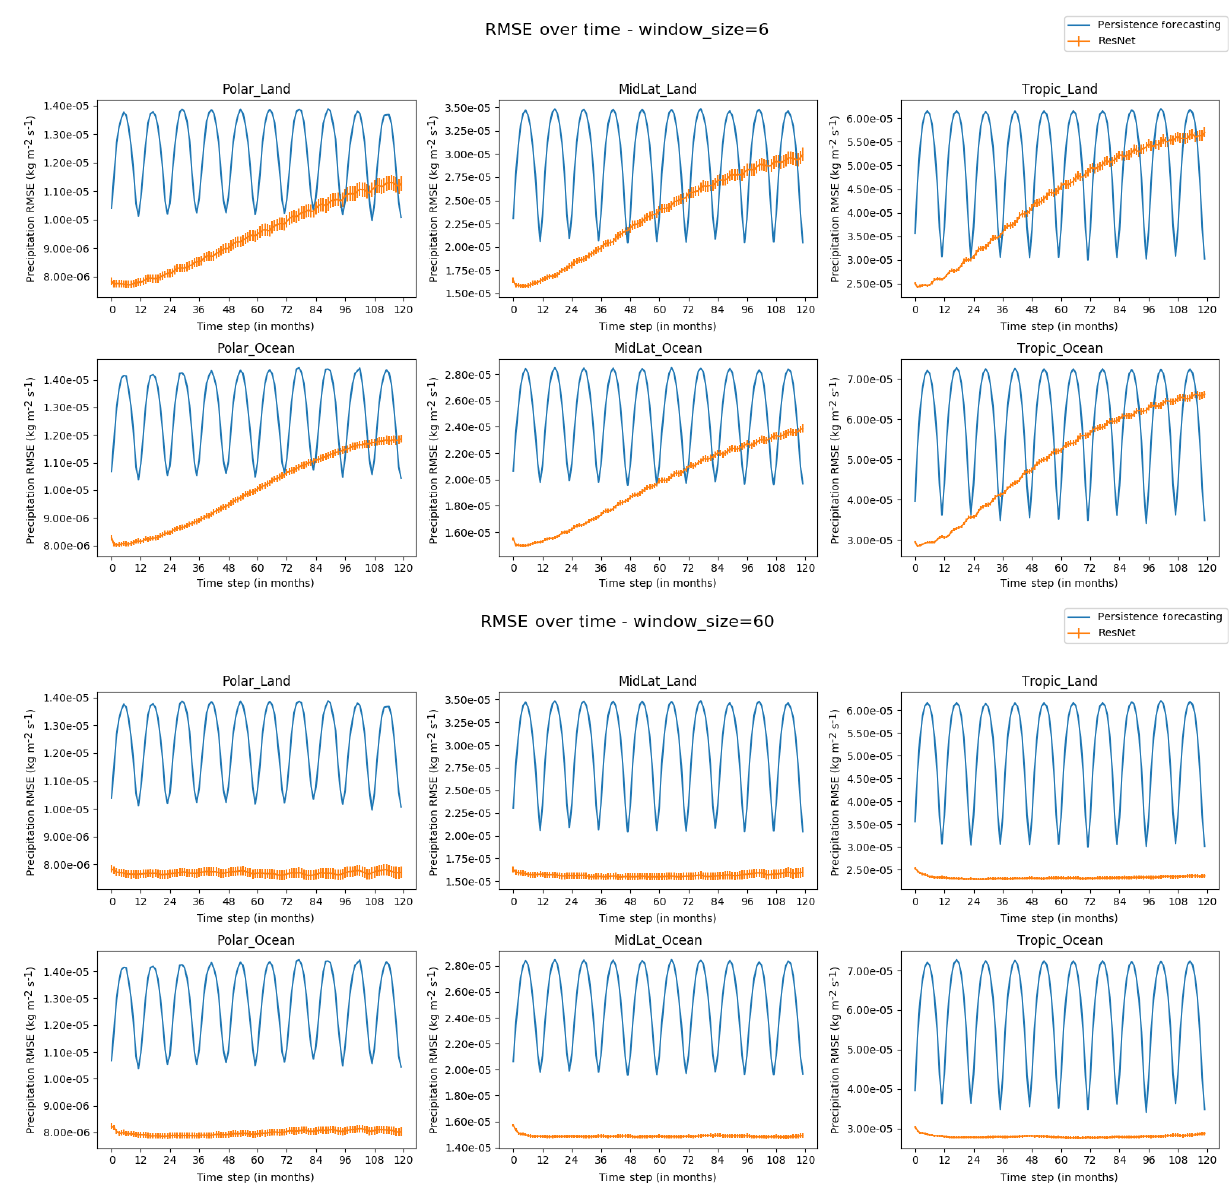
Figure A1. Comparing the RMSE for decadal precipitation forecasts in the 18-layer residual network with a 6-month window (top) and a 60-month window (bottom). Both networks were trained using scheduled sampling, and preforecasting was not employed when generating